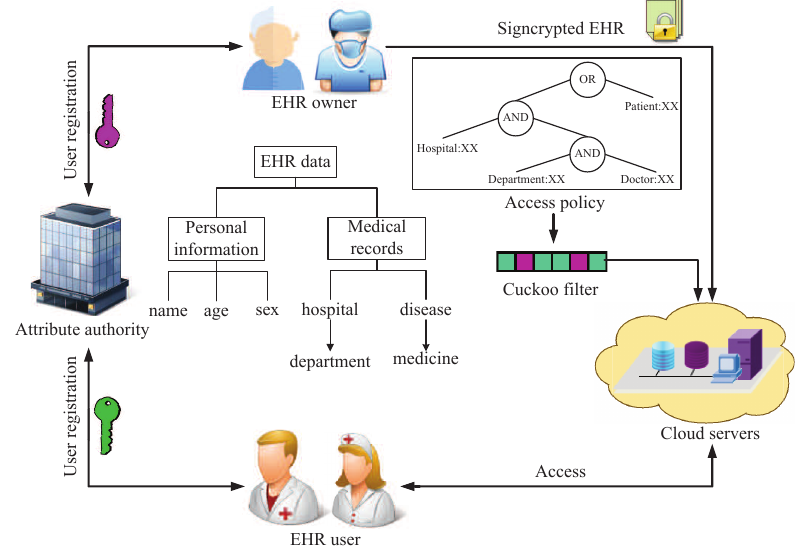
Figure 3. A framework of the EHR